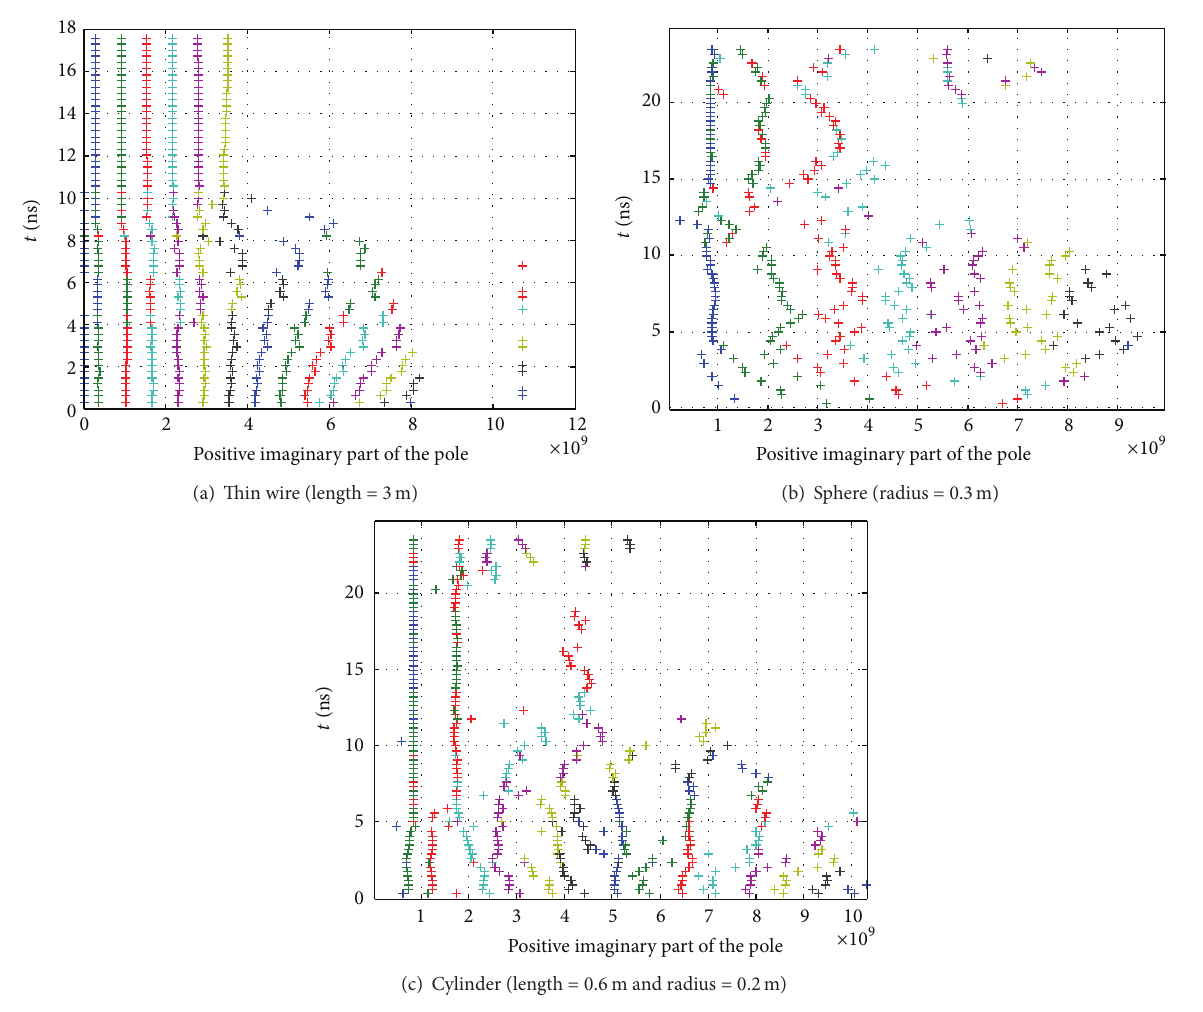
Figure 3: Variation of positive imaginary part of the poles with sliding